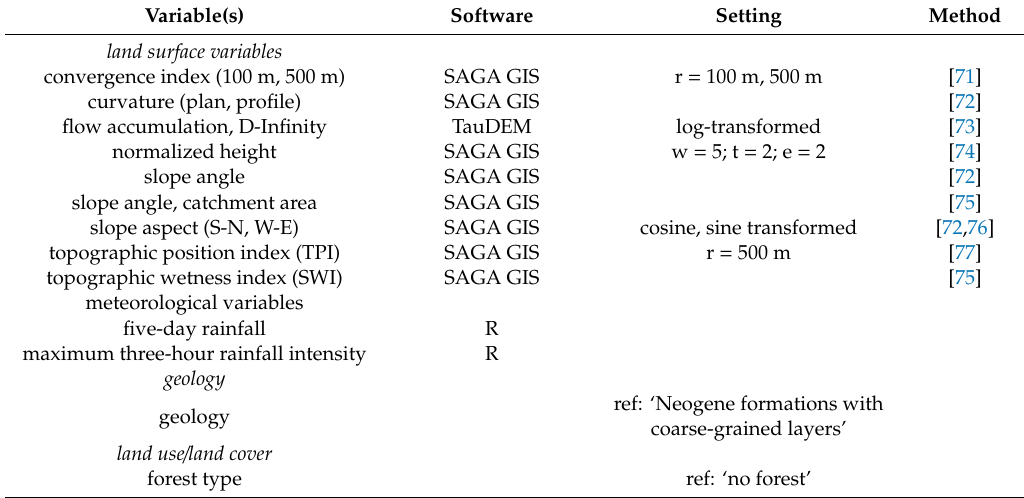
Table 1. Predictor variables used in this